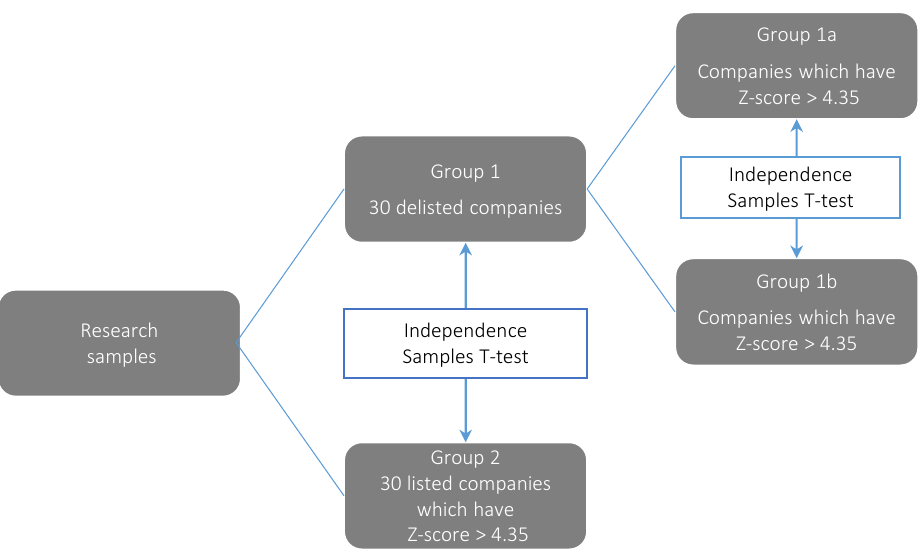
Figure 1. Elements of the